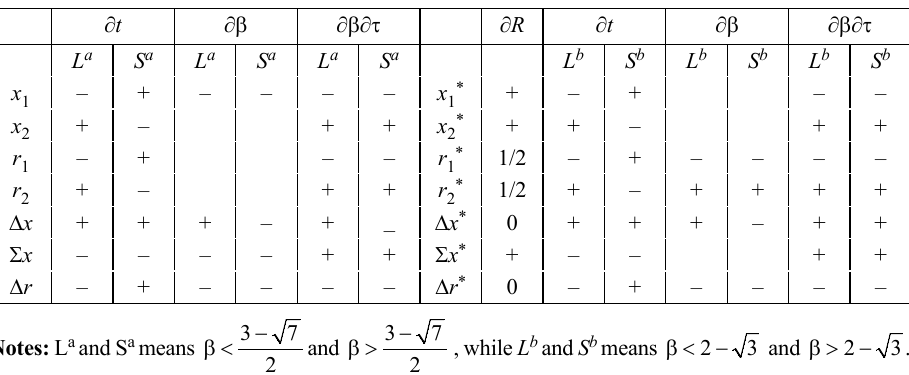
Table 1. The relationships between variables and